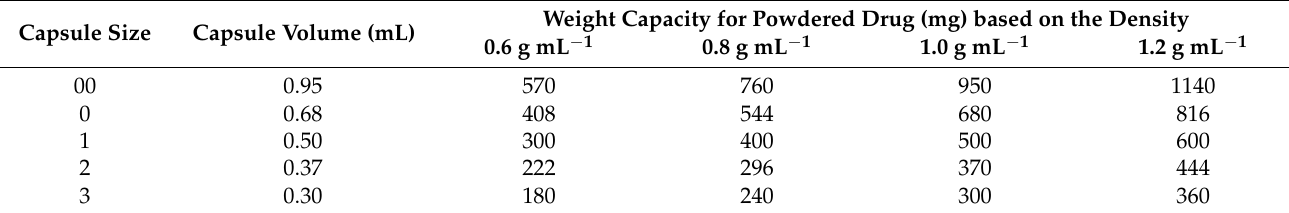
Table 5. Capacity specification of hard gelatine capsules.